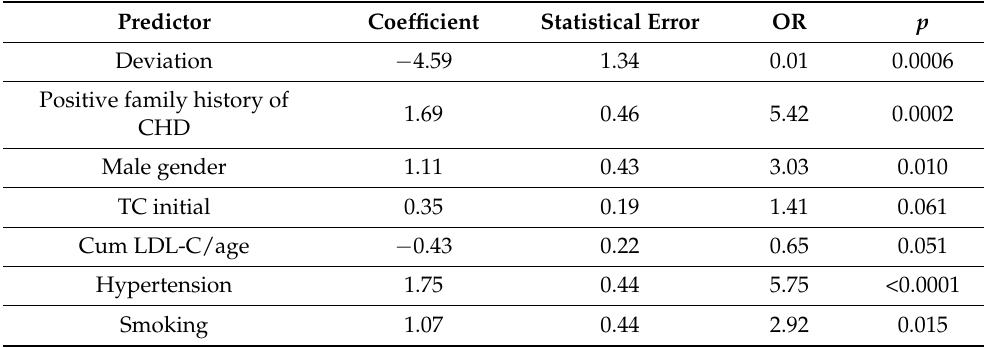
Table 6. Statistical significance of coefficients in calculating the odds ratio of MI in FH patients (logistic regression).